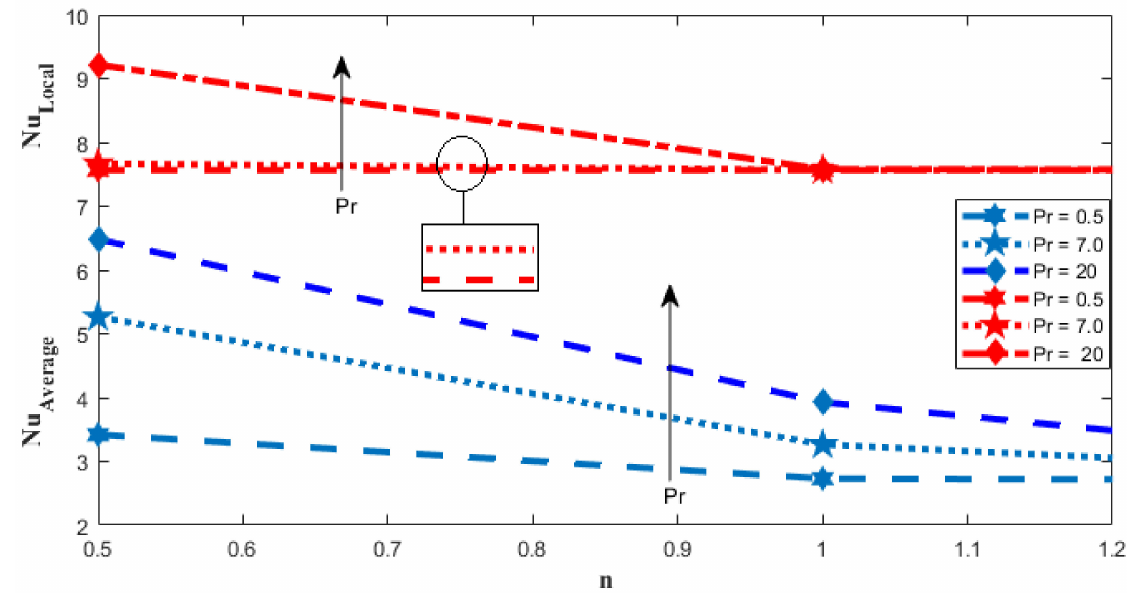
Figure 9. Variation in Nusselt number against ( Pr ) and ( n ).